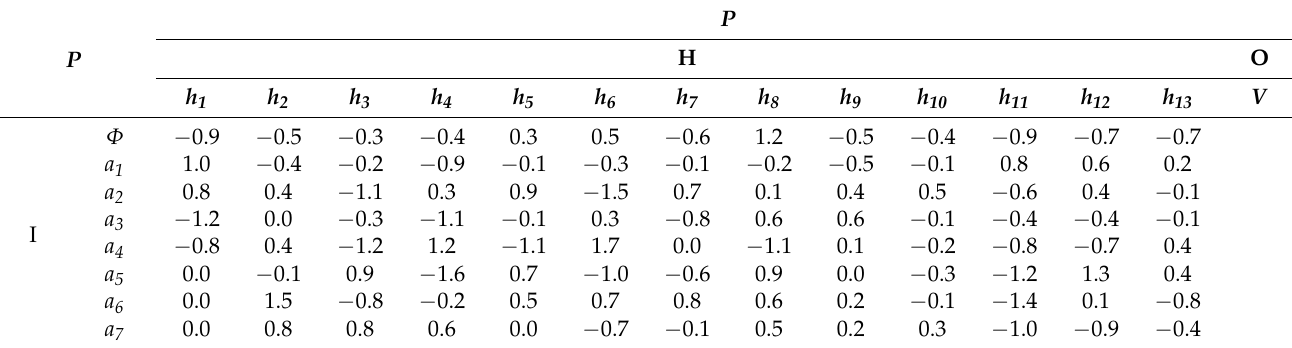
Table 4. Layer-to-layer connection weights for the predictive model of PE